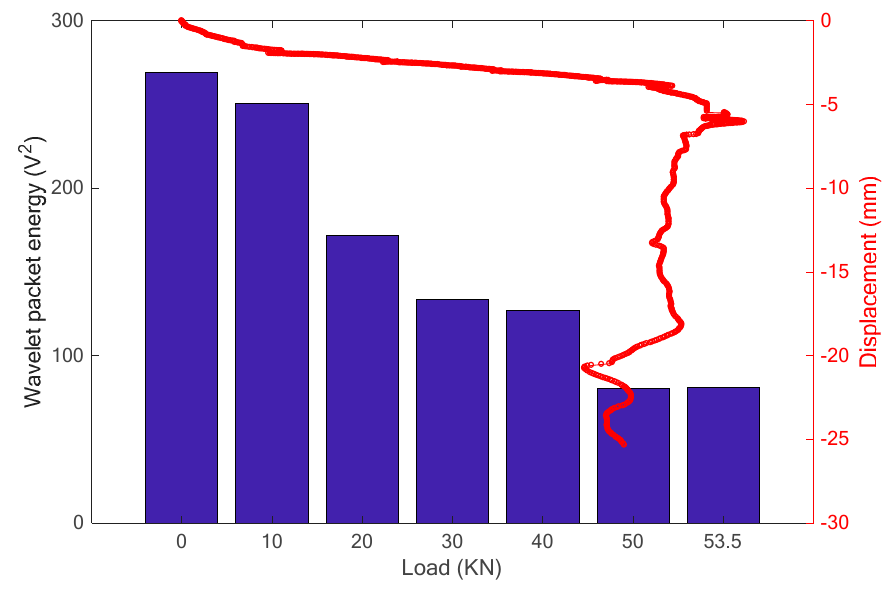
Figure 9. The results of wavelet packet energy.